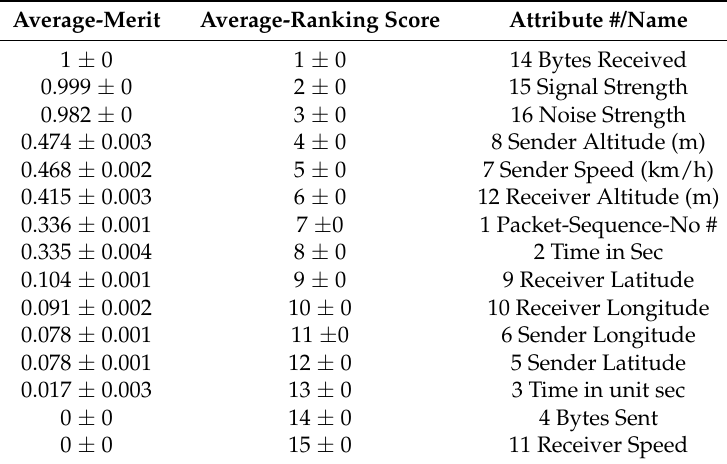
Table 3. Attribute ranking score card.